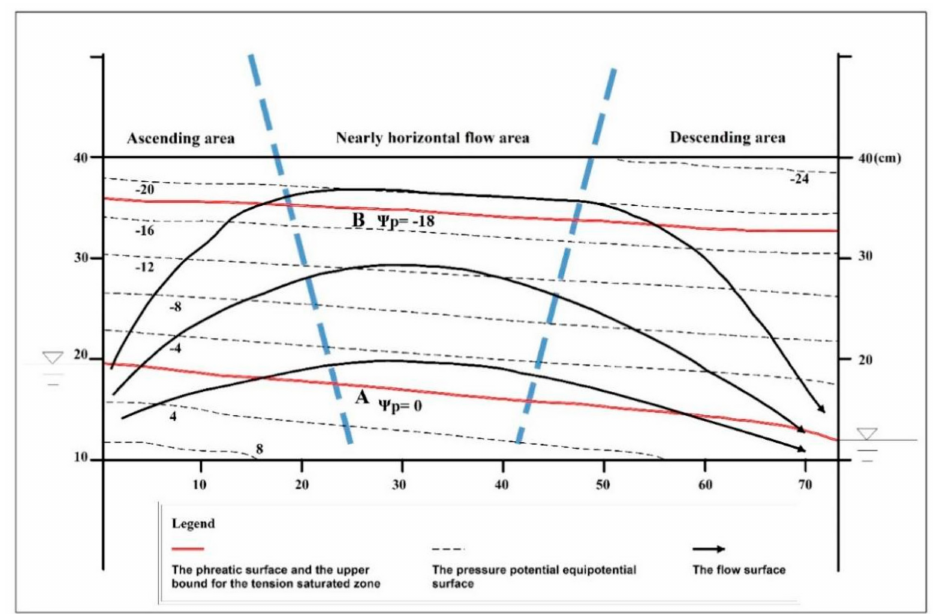
Figure 5. Pressure potential distribution as measured in the physical